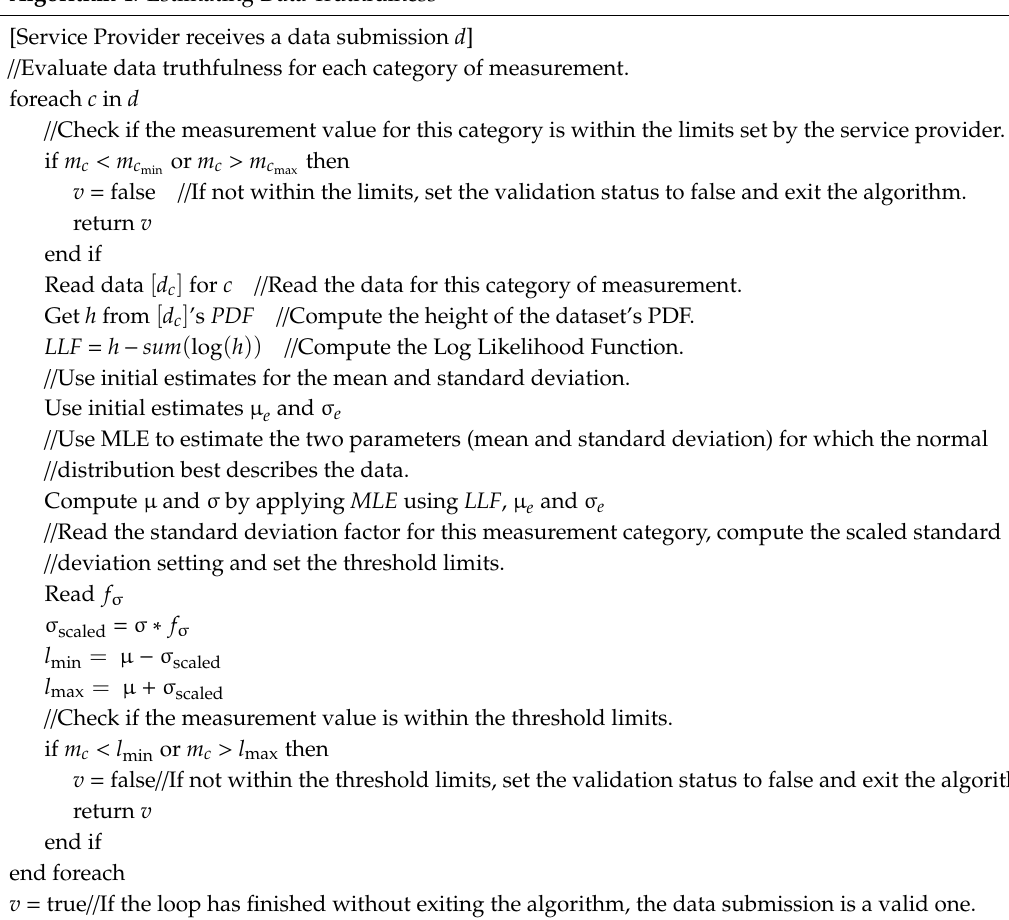
Algorithm 4 : Estimating Data